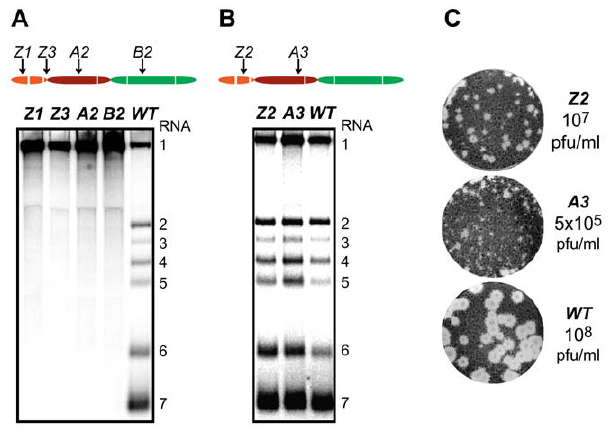
Figure 3. Importance of nsp1 subdomains for transcription and virus production. (A, B). Analysis of EAV-specific mRNA accumulation by gel hybridization. The domain organization of nsp1 is depicted as in Fig. 2 and the positions of the clusters of amino acid mutations analyzed are indicated with arrows. BHK-21 cells were transfected with RNA transcribed from wt or selected mutant EAV full-length cDNA clones. Total intracellular RNA was isolated at 11 h post-transfection and resolved by denaturing formaldehyde electrophoresis. Equal loading of samples was confirmed by ethidium bromide staining of ribosomal RNA (data not shown). EAV-specific mRNAs were detected by hybridization of the gel with a 32 P-labelled probe complementary to the 3 9 -end of the viral genome and subsequent phosphorimaging. The positions of the EAV genome (RNA1) and the six sg mRNAs (RNA2 to RNA7) are indicated. (C) Plaque phenotype and virus titers of the Z2 and A3 mutants. Plaque assays were performed on BHK-21 using cell culture supernatants harvested 24 h after transfection. Cells were incubated under a semi-solid overlay at 39.5 u C for 72 h, fixed and stained with crystal violet. Virus titers represent an average of three